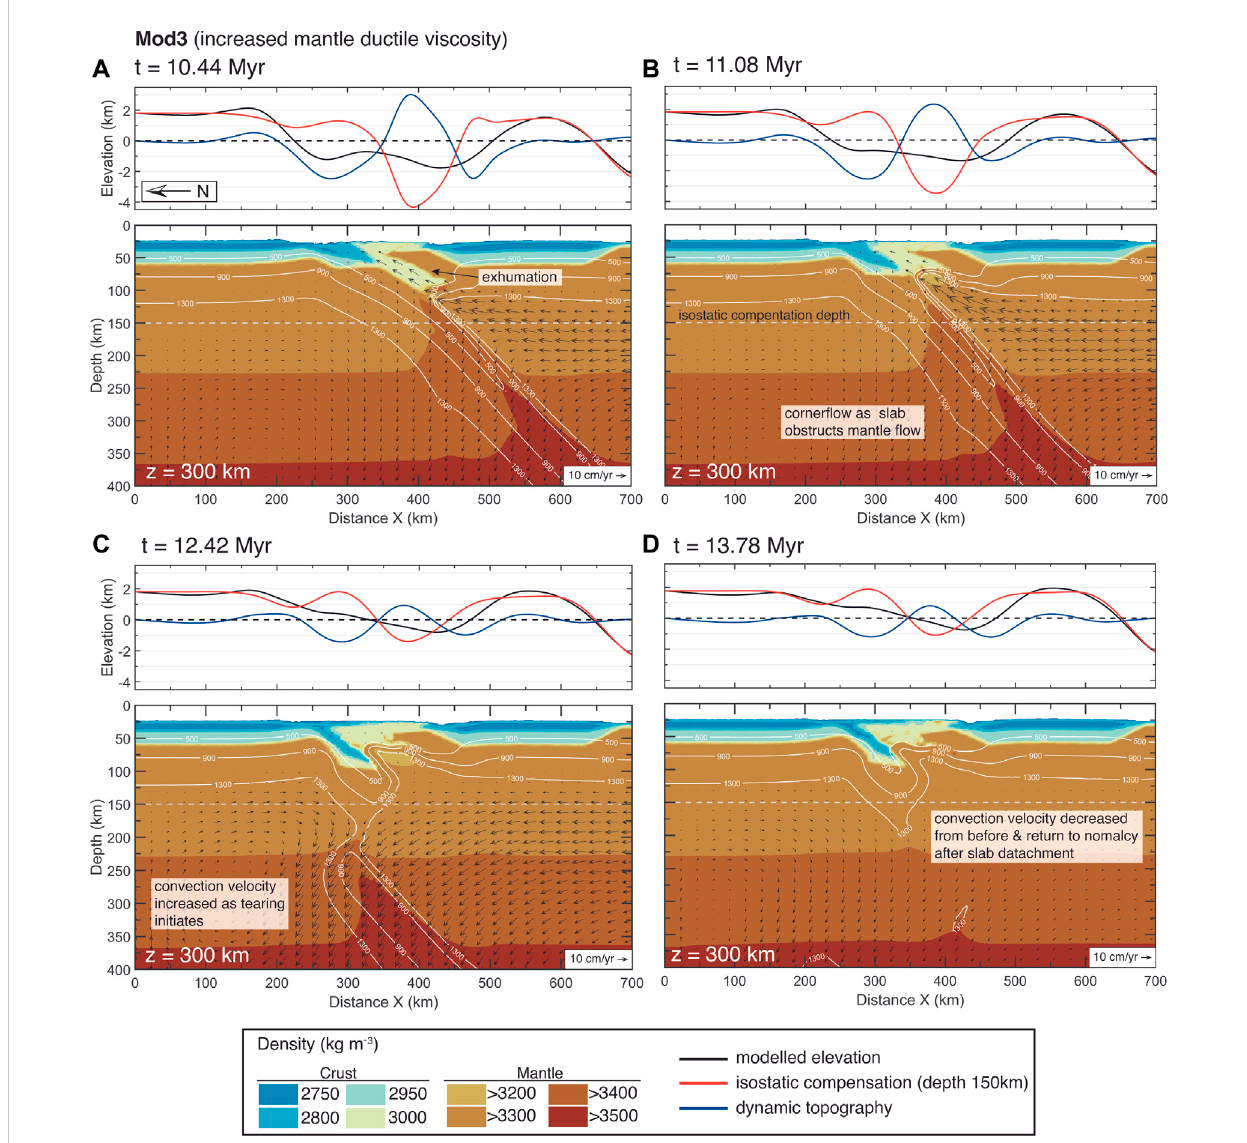
FIGURE 7 Dynamic topography and density for model Mod3 (higher mantle ductile viscosity). The elevation plots (top panels) consist of: 1) total elevation resulting from the model (black); 2) component of elevation corresponding to isostatic compensation of the crust (red); and 3) component related to dynamic topography (blue). The isostatic effect is calculated with a compensation depth of 150 km (~128 km below crustal surface). The density (kg/m 3 ) distribution (bottom panels) is overlaid with temperature contours of the lithospheric mantle (500 ° C, 900 ° C, and 1,300 ° C). (A) From the stage when theincomingcontinentalblockcametoacompletestop. (B) Pre-detachmentstagewithongoingexhumationofthesubductedoceaniccrustandcorner fl ow as the slab obstructs mantle fl ow. (C) During necking and tearing when mantle fl ow focus on the detaching slab and decrease the convection velocity in the upper part of the mantle. (D) Post-detachment stage when the mantle fl ow returns to its unperturbed state and convection velocity are reduced (the detached slab is at 450 – 660 km